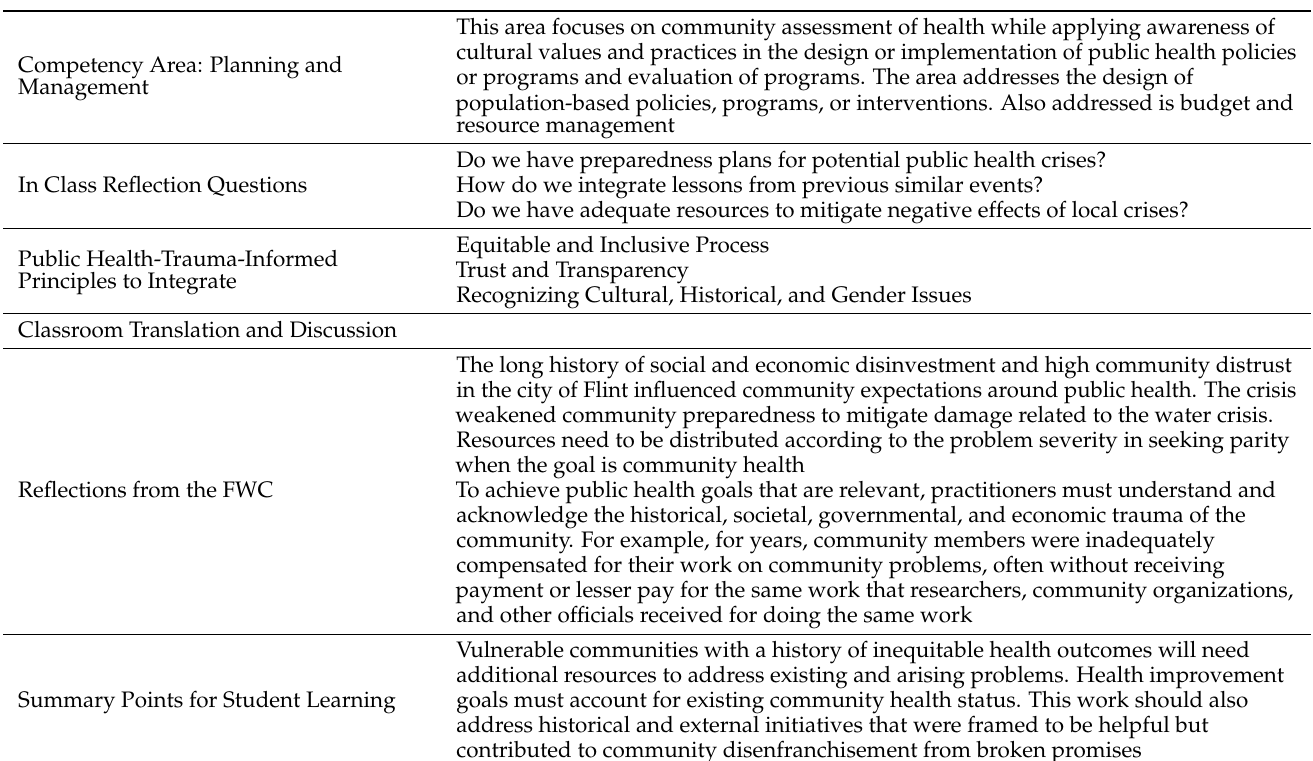
Table 3. Trauma-Informed Principles in Public Health: Addressing Public Health Planning and Management with Examples from the Flint Water